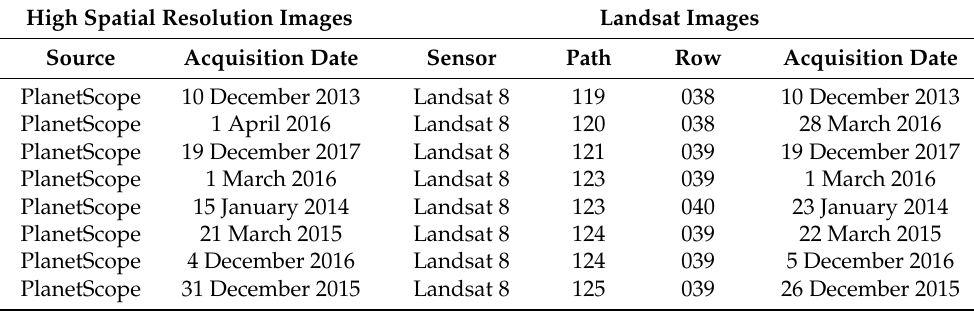
Table 1. High spatial resolution images and corresponding matched Landsat images selected for accuracy assessment. High Spatial Resolution Images Landsat